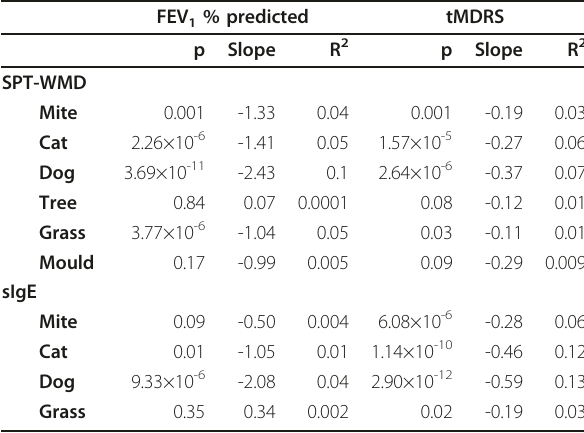
Table 6 Quantification of IgE and SPT and FEV 1 % predicted and tMDRS amongst sensitised